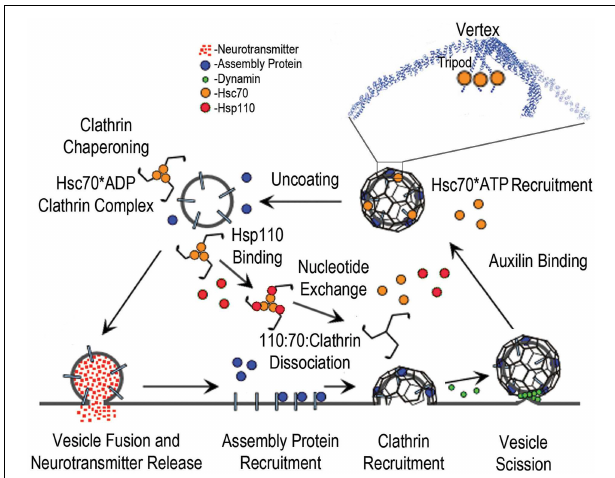
FIGURE 1 | The synaptic vesicle cycle and the roles of Hsc70, Auxilin, and Hsp110. The cycle begins with synaptic vesicle fusion and release of neurotransmitter. Assembly/adaptor proteins then bind to the synaptic vesicle membrane proteins and phosphoinositides, and recruit clathrin; leading to membrane invagination and subsequent vesicle scission by dynamin (green spheres), followed by binding of auxilin, which recruits Hsc70 * ATP (orange spheres) to the vesicle coat. The boxed region of the coated vesicle is expanded to show how Hsc70 binds to the flexible C-terminal tails that emerge from the helical tripod that is positioned under each vertex of the clathrin coat. Hsc70-driven disassembly (uncoating) of the coat follows, resulting in stable Hsc70 * ADP:Clathrin complexes. Hsp110 binding then induces ADP to ATP exchange and dissociation of the Hsp110:Hsc70:Clathrin